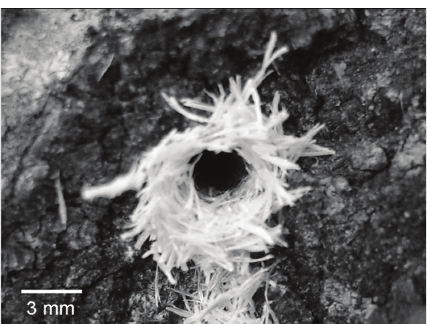
Figure 1: Crown-like arrangement in P. canadensis surrounding the entrance to the nuptial gallery built with the particles of boring dust (frass) produced by the male M. mutatus from where volatiles are emitted to attract individuals of the opposite